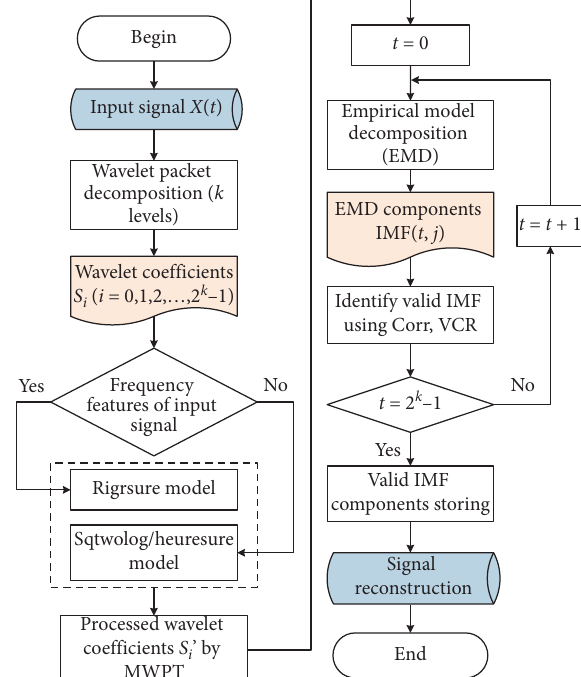
Figure 3: Flow chart of the